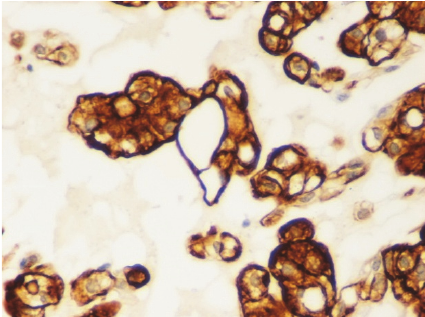
Figure 2: Positivity of the tumor cells for EMA (20x).